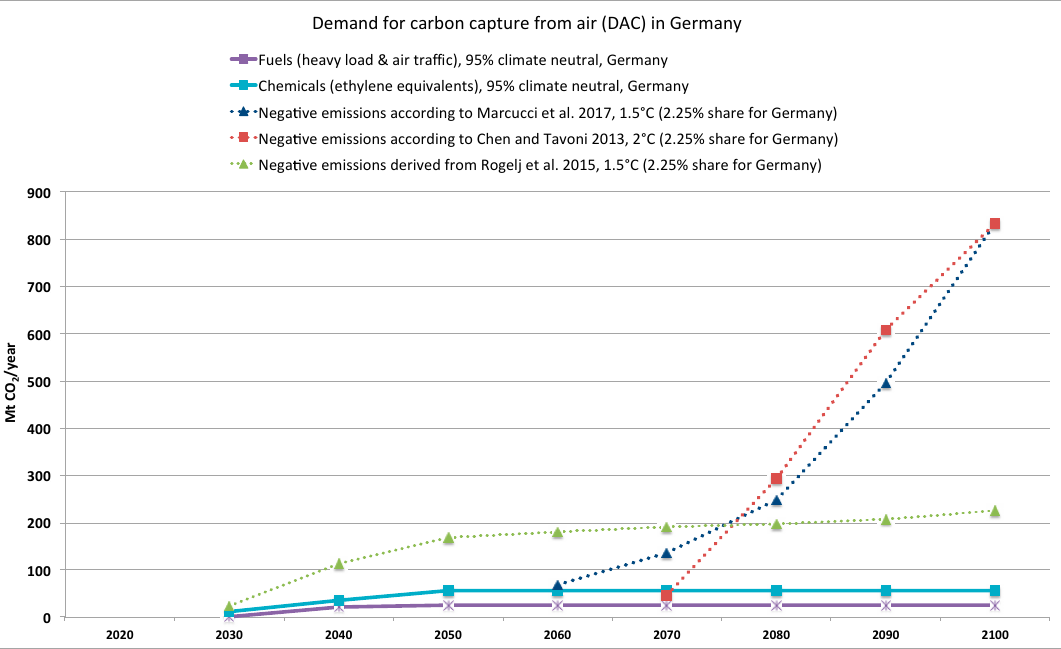
Figure 3. German demand for Direct Air Capture (DAC) for negative emissions according to Germany’s share of global CO 2 emissions (dotted lines), compared to the German demand for carbon neutral CO 2 for Power-to-Liquids (PtL) and Power-to-Chemicals (PtC) (solid lines) in Mt CO 2 /year.